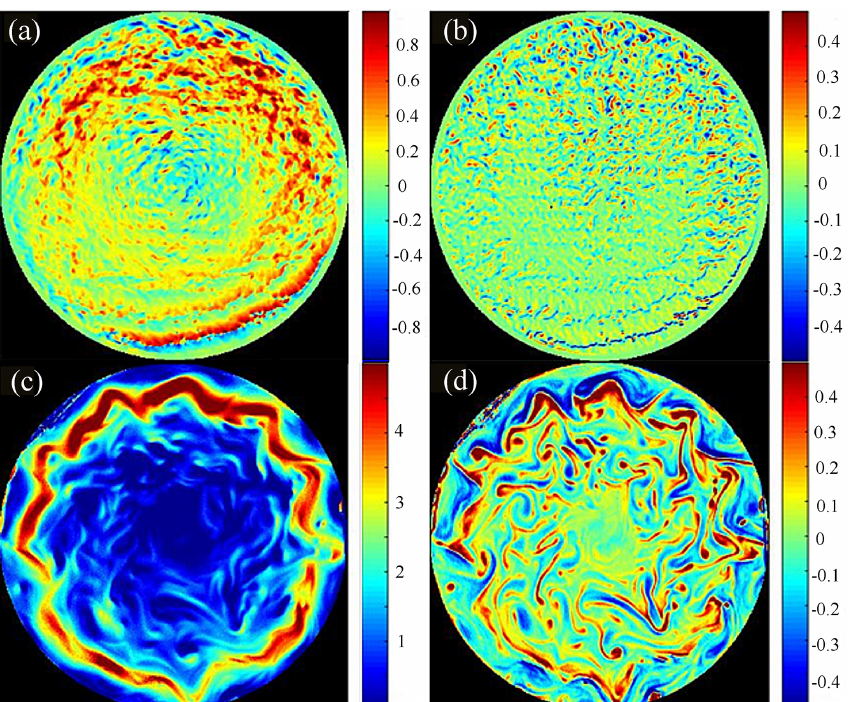
Figure 3. Flows generated by thermal forcing at t = 280s (a, b) and by saline forcing at t = 150s (c, d) . (a) and (c) show the x component of velocity (azimuthal velocity) u , while (b) and (d) show the dimensionless relative vorticity, ζ/f 0 . The salinity difference between the layers for the experiment with saline forcing (a, b) is S = 30ppt. The centre of the tank corresponds to the North Pole of the polar β